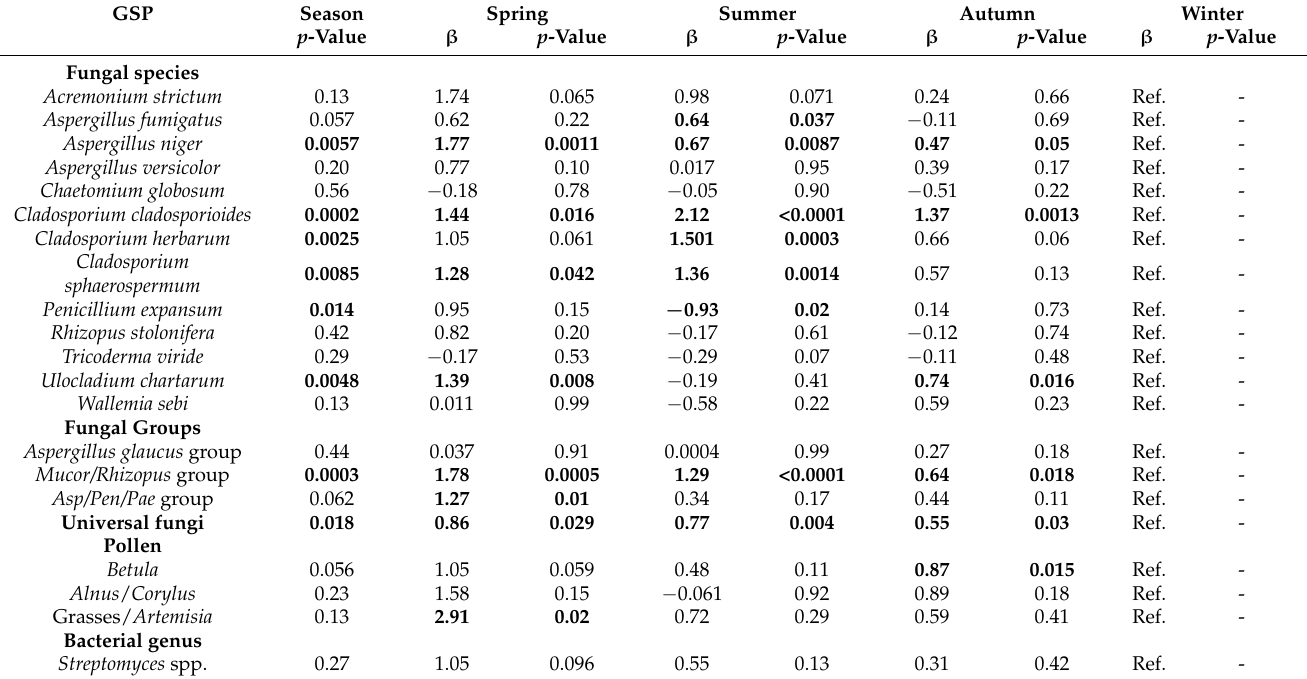
Statistically significant values are in bold . β ( β -coefficient) is the estimate of each season. A positive β -coefficient means there is an elevated concentration in the season. A mixed-effects linear regression model was used with the home as a random effect and season as a fixed factor. Winter was chosen as the reference (Ref.). Table 3. Seasonal differences between the concentrations of DNA copies in the GSP